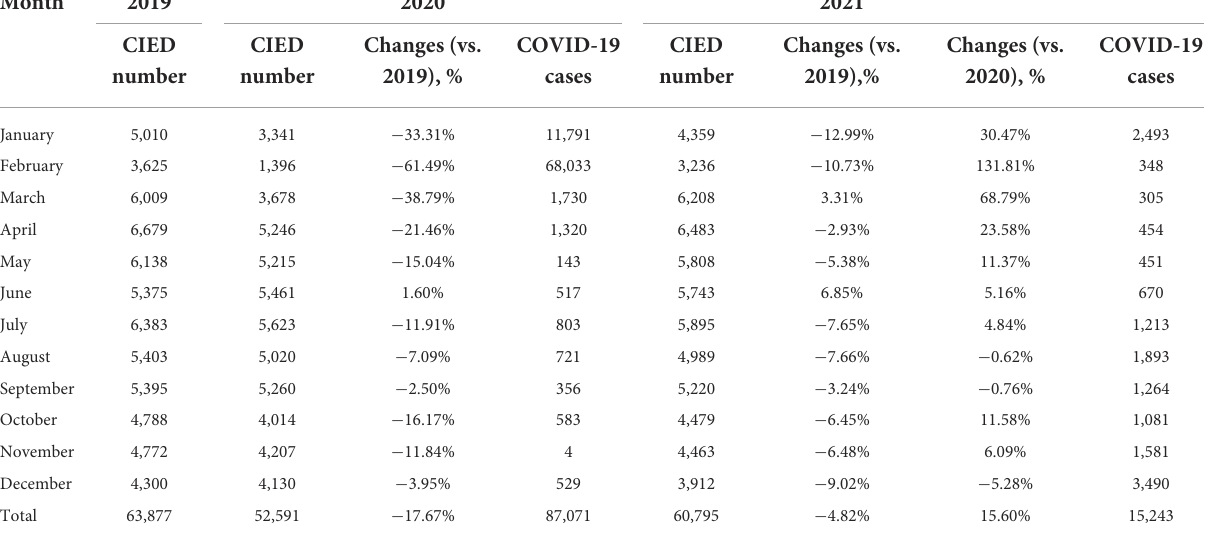
TABLE 1 The monthly number of CIED implantation and confirmed COVID-19 cases from 2019 to